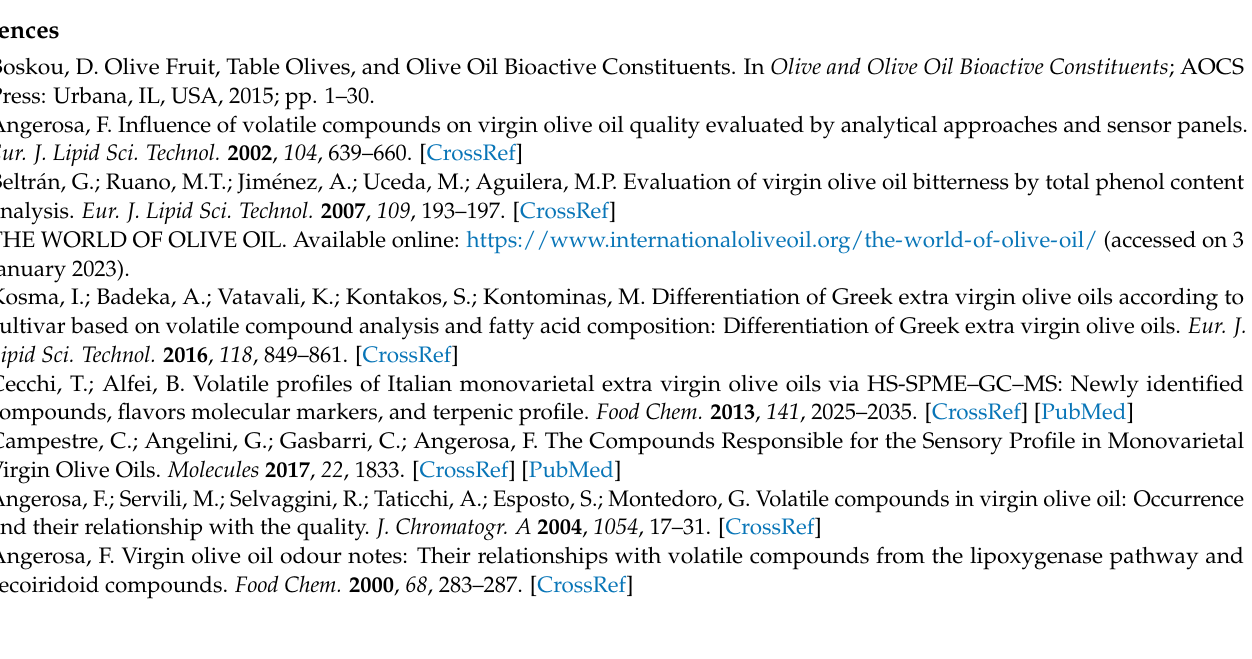
analyzed. Table S2: Volatile composition of EVOOs according to the olive tree cultivar. The values represent the mean content (%) of the samples in each variety. Data in the same row with different lowercase letters differ significantly ( p < 0.05). ADR: Adramytini variety; KOL: Kolovi variety; KOR: Koroneiki variety. Figure S1: Weighted regression coefficients (Bw) plot of volatile compounds identified in EVOOs from Koroneiki and Kolovi cultivar. The error bars denote uncertainty limits that correspond to 2 standard deviations. Variables with uncertainty limits that do not cross the zero line are significant (shaded bars) for class (cultivar) separation. Figure S2: Prediction with the external validation data set. The predicted Y value 0 corresponds to the KOR variety and the predicted Y value 1 to KOL variety. The predicted response of the validation samples is shown with a red horizontal line. The vertical red lines indicate the root mean squared error (RMSE). The blue box spans the deviation in both directions and is an estimate of the prediction uncertainty. Figure S3: Inliers vs. Hotelling’s T2 plot of the predicted olive oil samples (blue dots) used in external validation of PLS-DA model. The associated critical limits (with a p-value of 5%) are displayed as horizontal and vertical red lines. Figure S4: Permutation test of the OPLS-DA model. Figure S5: (a) ROC curves of all models resulted from the automated combination of 2, 3, 5, 10, 20 and 28 volatile compounds. The legend presents the AUC value and the corresponding confidence limits (CLs) for each model. (b) Plot of the predicted accuracies of each model with an increasing number of features (volatile compounds). The most accurate model is highlighted with a red dot. (c) Plot of the most important features of the selected model, ranked from most important to least